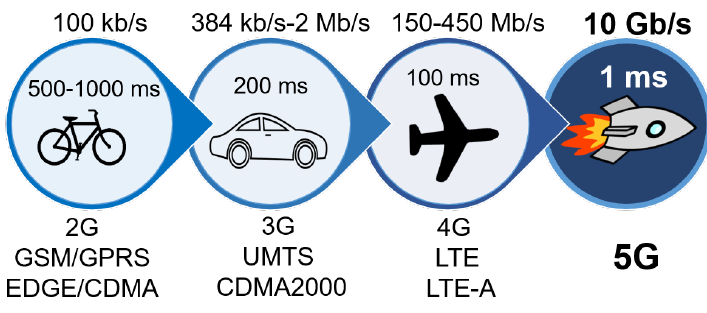
Figure 3. The performance trends (throughput and latency) of 2G, 3G, 4G and 5G wireless